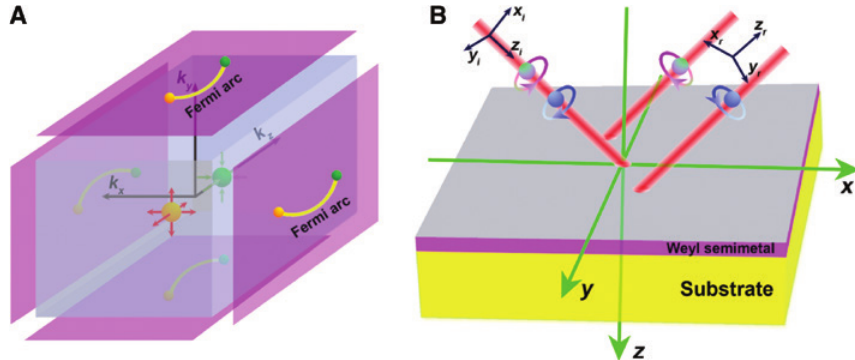
Figure 1: A schematic sketch of the calculation model. (A) Schematic k -space picture showing a bulk WSM with Fermi arcs on its surface of Brillouin zone. A pair of Weyl nodes along k represented by the orange and green pellets with outward arrows as sources and inward arrows as sinks of Berry curvature. Note that surfaces perpendicular to k axis do not support arcs. (B) Real-space illustration of the photonic spin splitting of one Gaussian beam reflected from an z ultrathin film of WSM. The purple surfaces of WSM host the arc surface states and gray surfaces are ones without arc surface